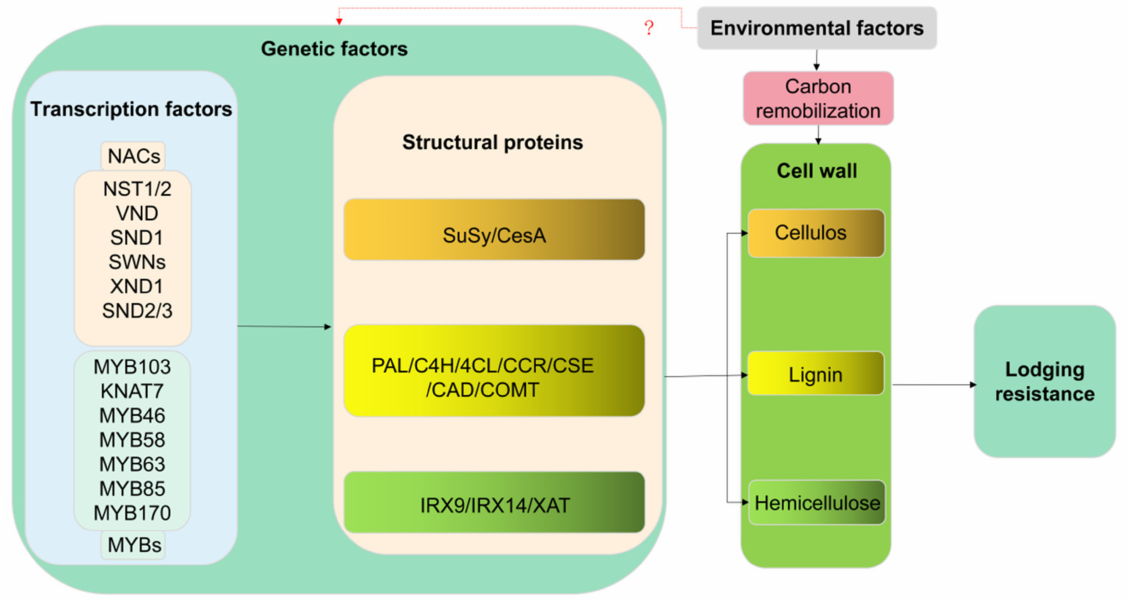
Figure 3. Environmental and genetic factors influence stem cell wall components to improve crop lodging resistance. NACs—NAC family transcription factors; MYBs—MYB family tran-